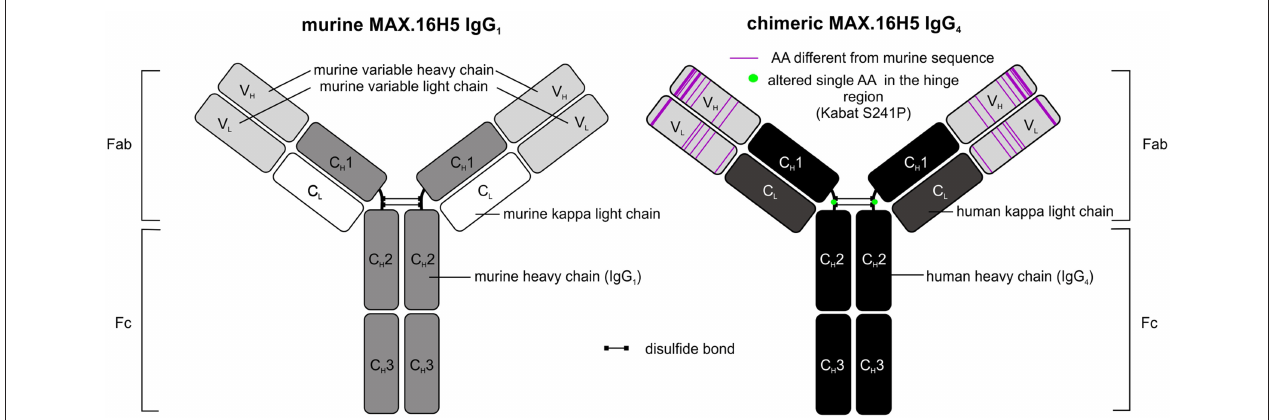
FIGURE 1 | Schematic representation of murine MAX.16H5 IgG 1 and chimeric MAX.16H5 IgG 4 antibodies.